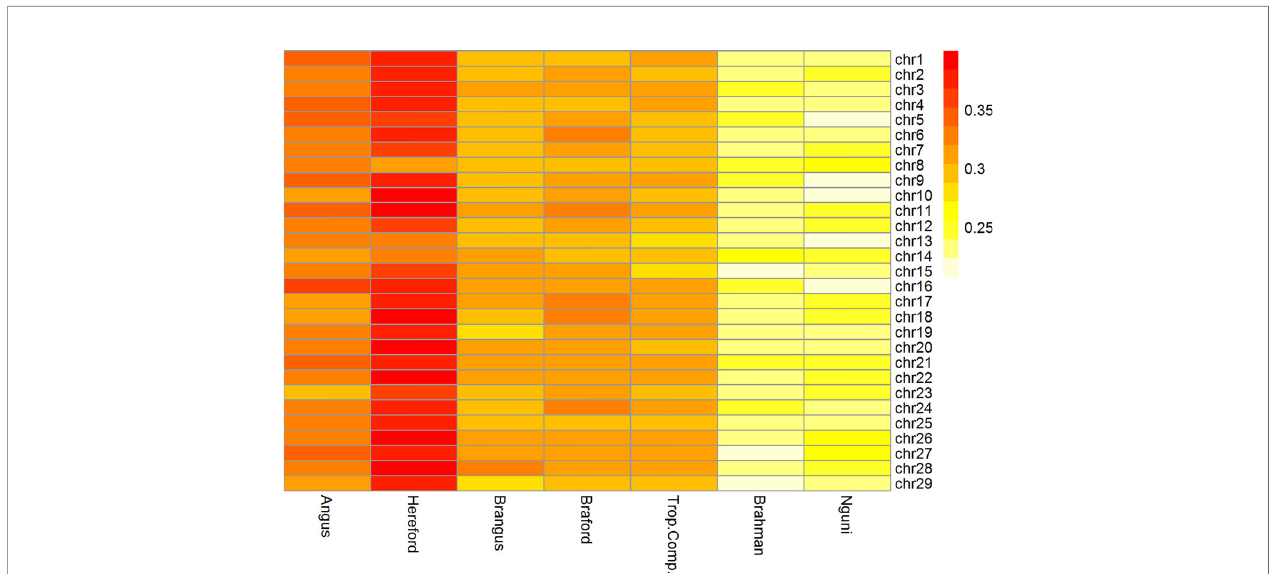
FIGURE 2 | Heatmap of linkage disequilibrium ( r 2 ) between adjacent markers of the 332k SNP panel by breed and